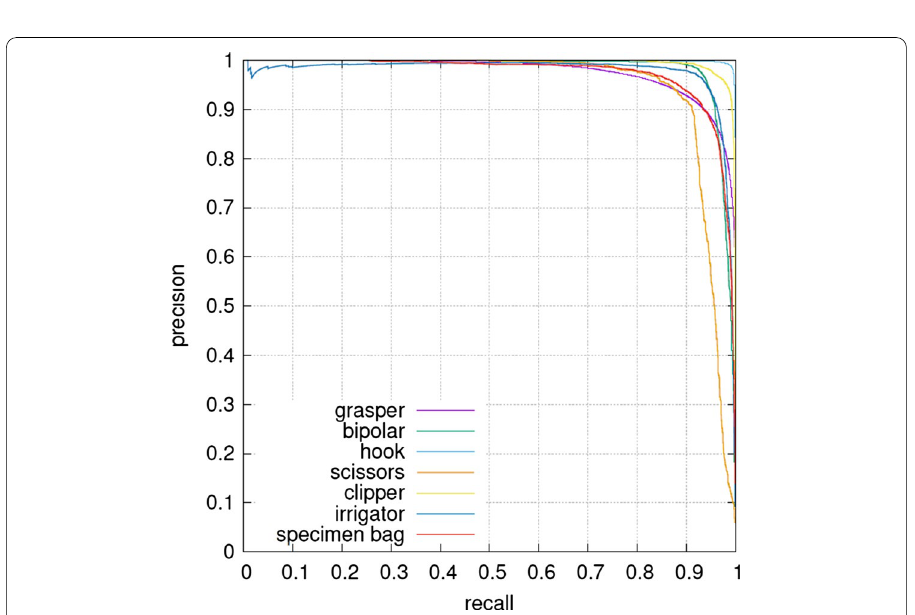
Fig. 12 Precision-recall (PR) curves for the best